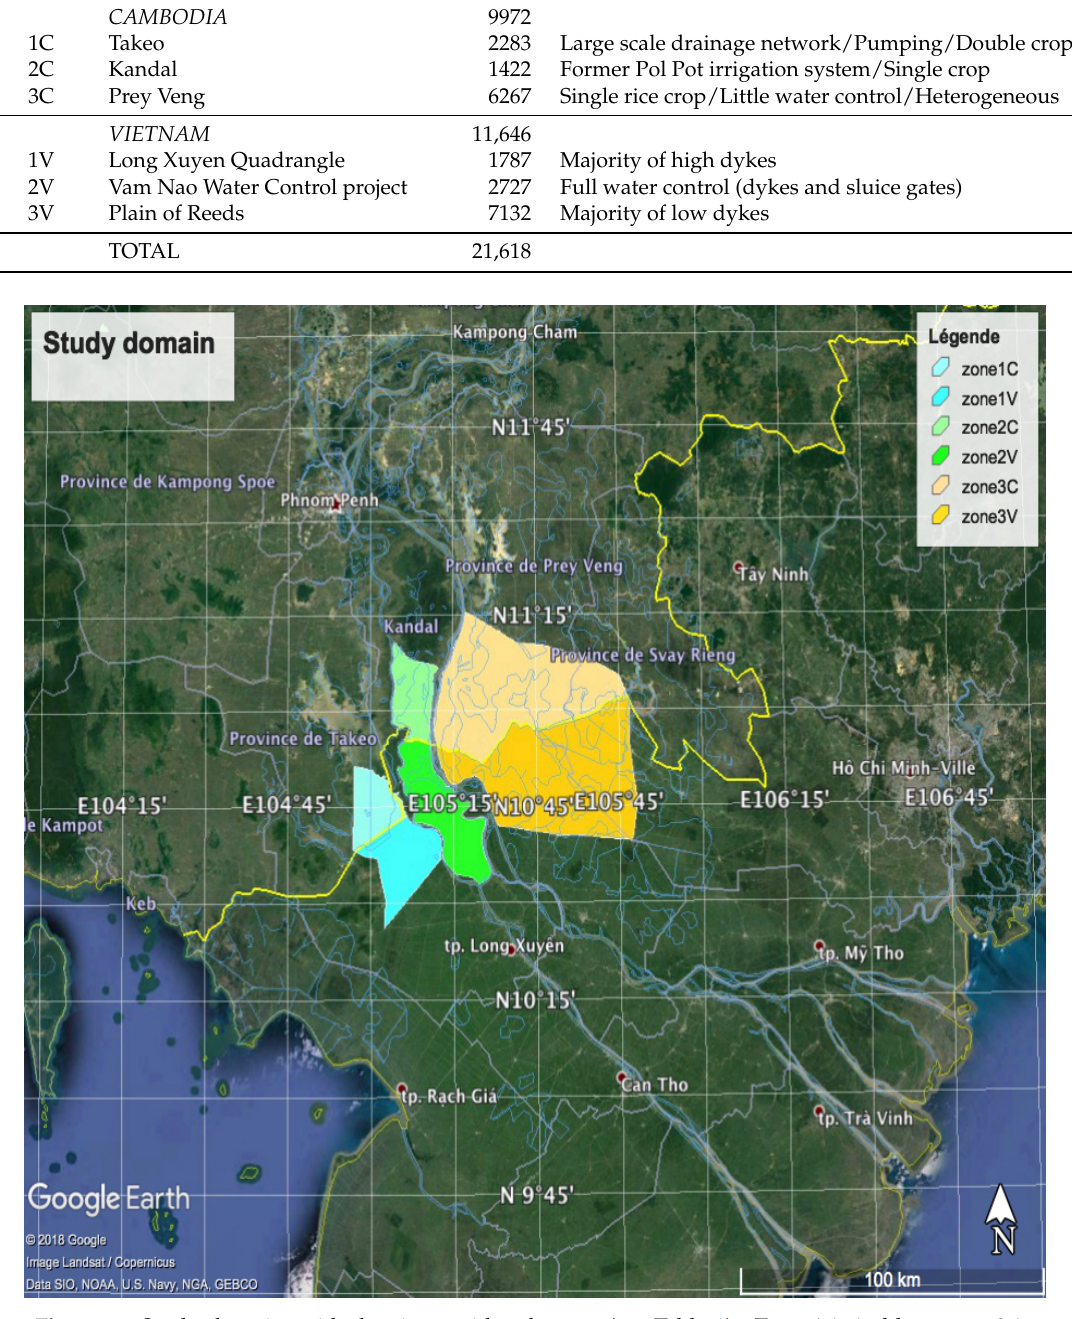
Figure 1. Study domain, with the six considered zones (see Table 1). Zone 1 is in blue, zone 2 in green, and zone 3 in yellow. Cambodian zones are in a lighter colour than Vietnamese ones. The Cambodia/Vietnam border is indicated in yellow. This full domain represents 21,618 MODIS pixels (500 m × 500